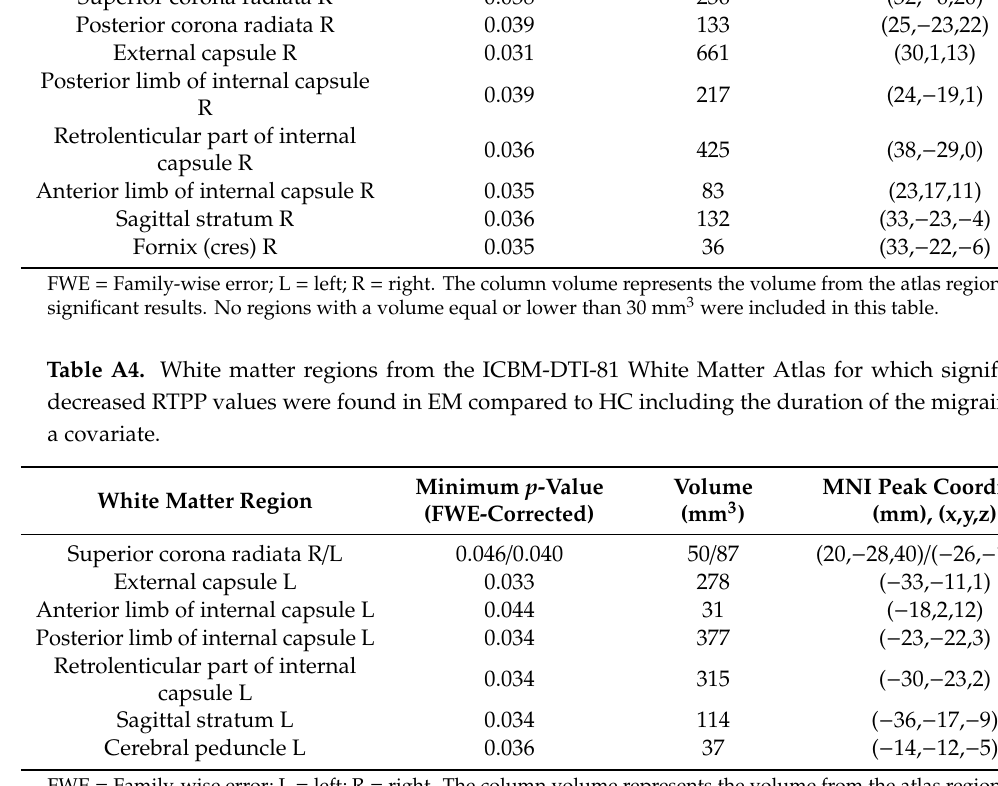
FWE = Family-wise error; L = left; R = right. The column volume represents the volume from the atlas region with significant results. No regions with a volume equal or lower than 30 mm 3 were included in this